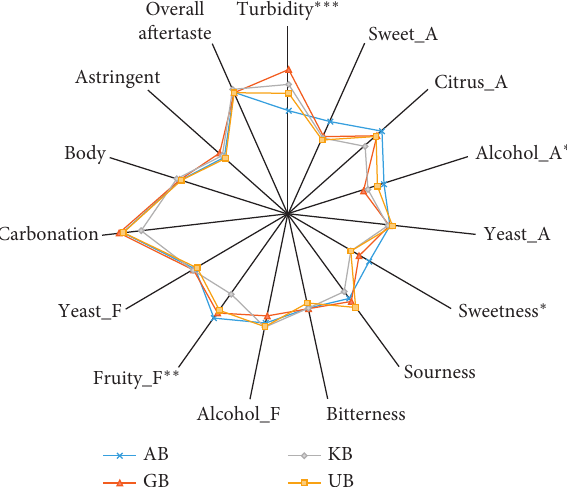
Figure 5: Sensory profiles of four beer samples by consumers ( n � 102). GB, UB, KB, and AB represent wheat beers made of grist containing 50% of wheat malt from German, USA, and Korean wheat variety ( Keumkang and Anzunbaengi ), respectively. A: aroma; F: flavour; ∗∗∗ p < 0 . 01, ∗∗ p < 0 . 05, and ∗ p < 0 . 10.